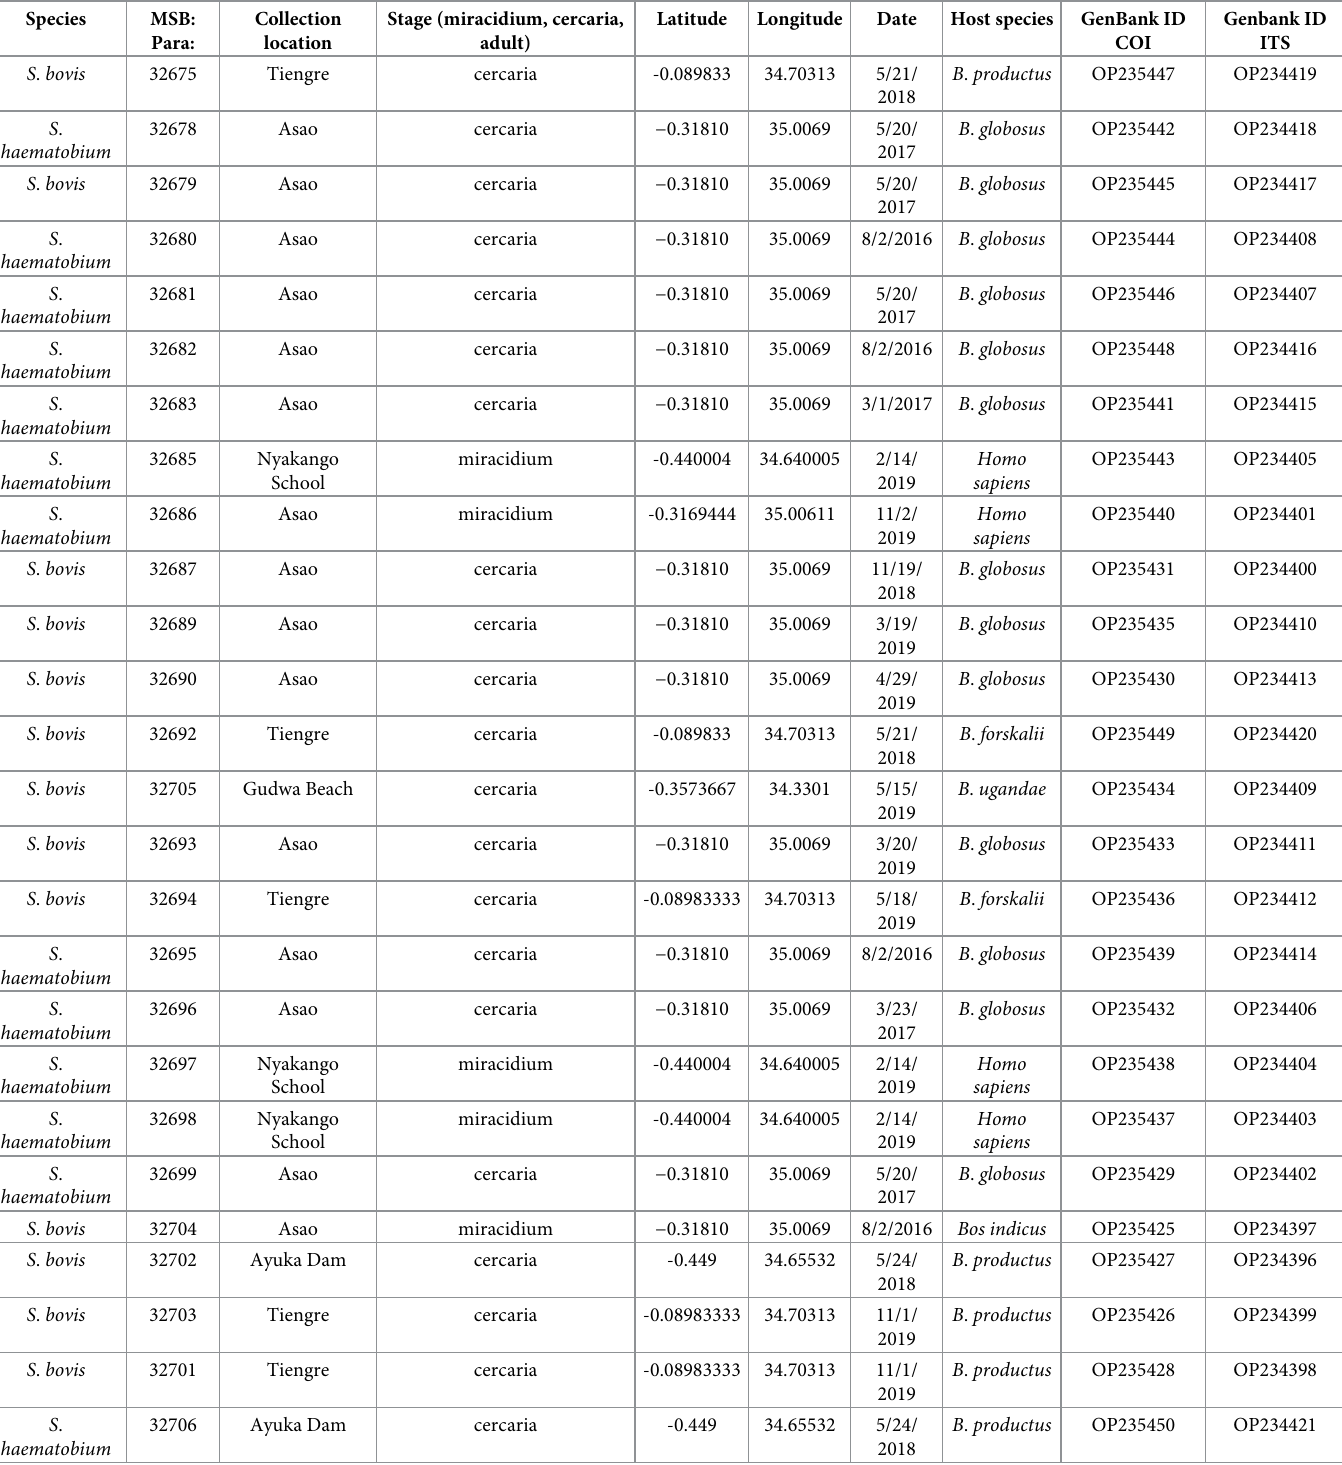
Table 3. Schistosome